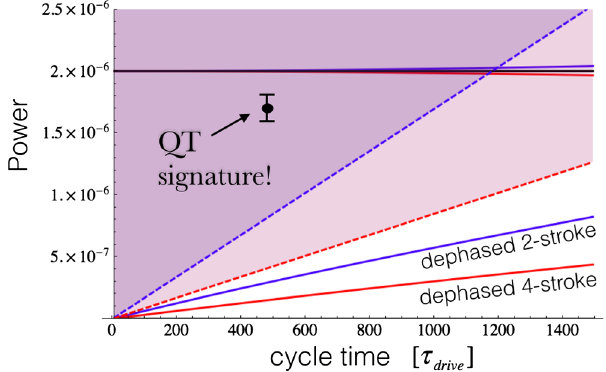
FIG. 9. The power output of the three types of engines (two- stroke blue, four-stroke red, continuous black) with and without dephasing [top horizontal solid lines are without dephasing — same as in Fig. 7(b)]. The power of the continuous dephased engine is zero. The dashed lines show the stochastic upper bounds on the power of two-stroke (dashed blue line) and four-stroke (dashed red line) engines. Any power measurement in the shaded area of each engine indicates the presence of quantum interfer- ence in the engine. This plot also demonstrates that for short cycle times (low action), coherent engines produce much more power compared to stochastic dephased